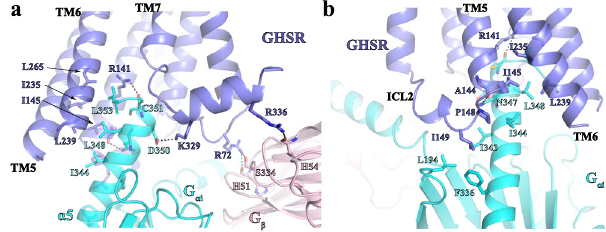
Fig. 5 GHSR and G i binding interface. a , b Detailed interactions between GHSR and G i viewed from two angles. GHSR, G α i , and G β are colored in blue, cyan, and pink, respectively. Polar interactions are shown as dashed